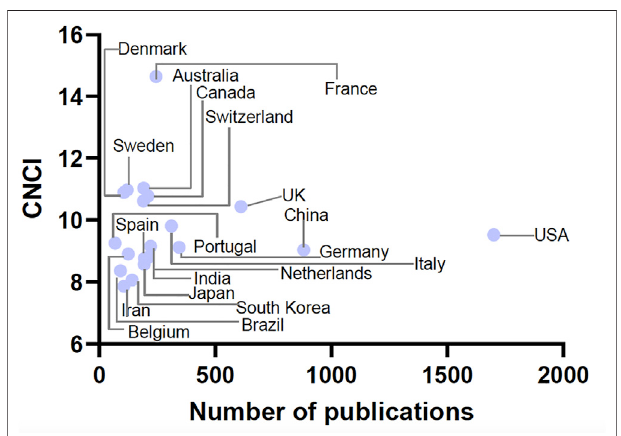
FIGURE 2 | Number of high-impact papers in pharmacology and pharmacy research and CNCI value by country.